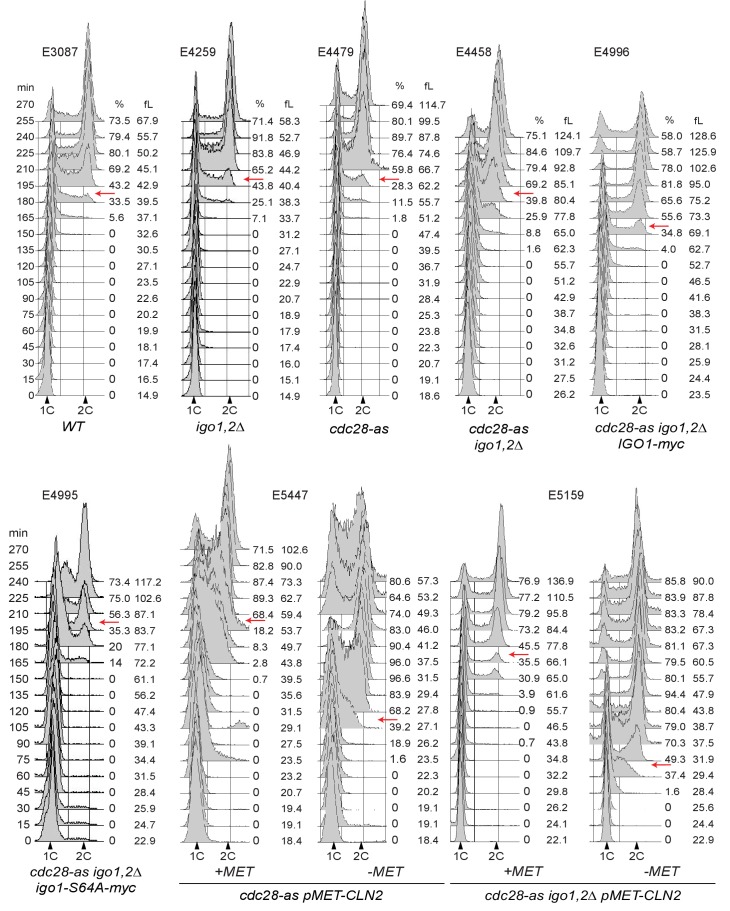
Cell cycle progression determined by FACS analysis of DNA content of elutriated early cells of the indicated genotype released in SC-D at 30°C.The peak cell size (in fL) and the budding index are given for each time point. BI, Budding index. The red arrow indicates when half of cells have budded. Elutriations were done three to six times independently for each strain; one example is shown (corresponding to Figure 3A–C). Strain number is indicated atop each histogram.